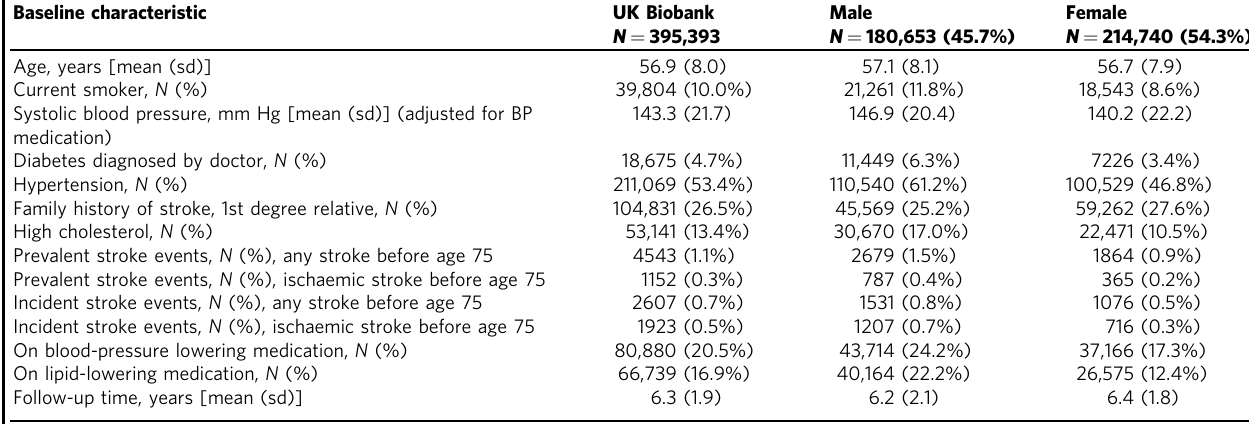
Table 1 Study characteristics of the UK Biobank validation dataset.